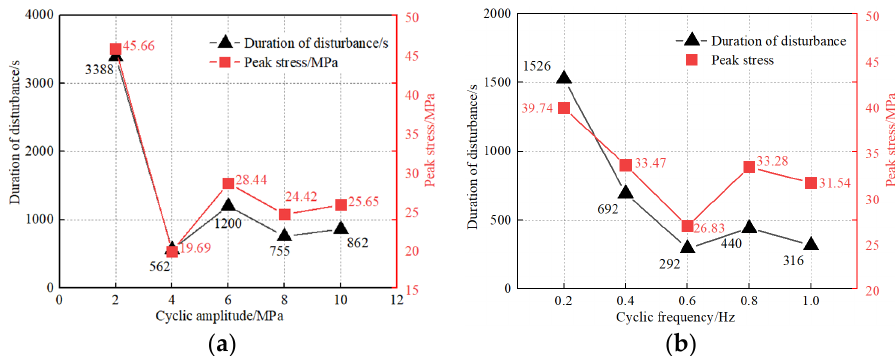
Figure 7. Relationship of control variables and cyclic stress parameters: ( a ) cyclic amplitude; ( b ) cyclic frequency.